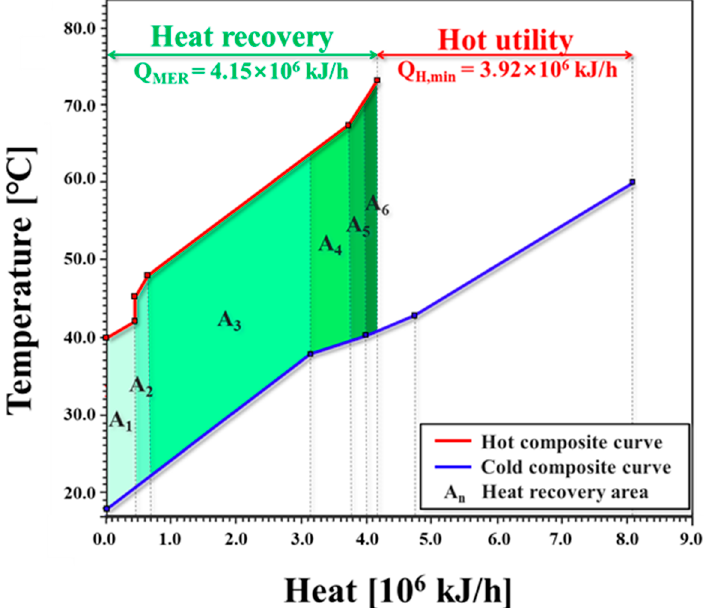
Figure 2. Hot and cold composite curves of the HEN in the wastewater heat recovery system.